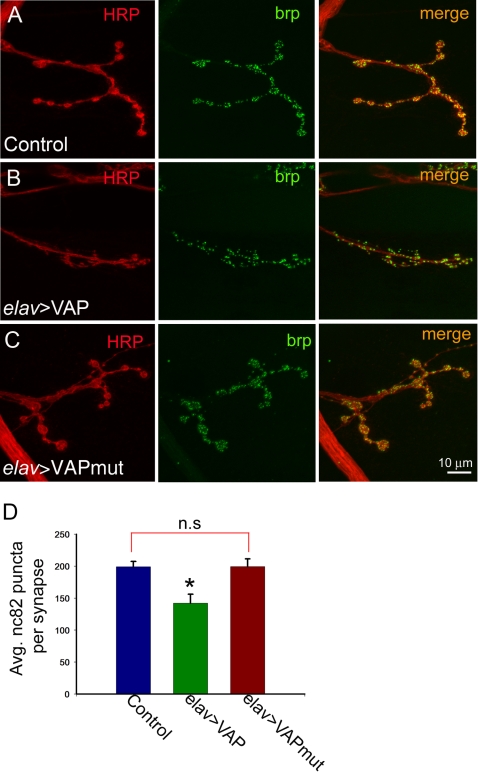
Neuronal overexpression of VAPwt but not VAPP58S leads a reduction in active zones.(A–C) Confocal images of synapses at muscle 4 stained with anti-HRP (red) and nc82, which labels the active zone protein bruchpilot (brp, green). Control (A) and elav-GAL4/UAS-VAPP58S (C) animals showed similar numbers of nc82 immunoreactive puncta per synapse. In contrast, such puncta were fewer in elav-GAL4/UAS-VAPwt animals (B). (D) A histogram showing the difference in number of nc82 positive puncta in all 3 genotypes. In elav-GAL4/UAS-VAPwt animals, an average of 142±14 puncta per synapse were observed (n = 18) as compared to 199±8.4 (n = 17) and 199±12 (n = 16) in control and elav-GAL4/UAS-VAPP58S animals, respectively (*, different from other two genotypes, p<0.001, ANOVA with Sidak-Holm test). n.s., not significant. Scale bar, 10 µm